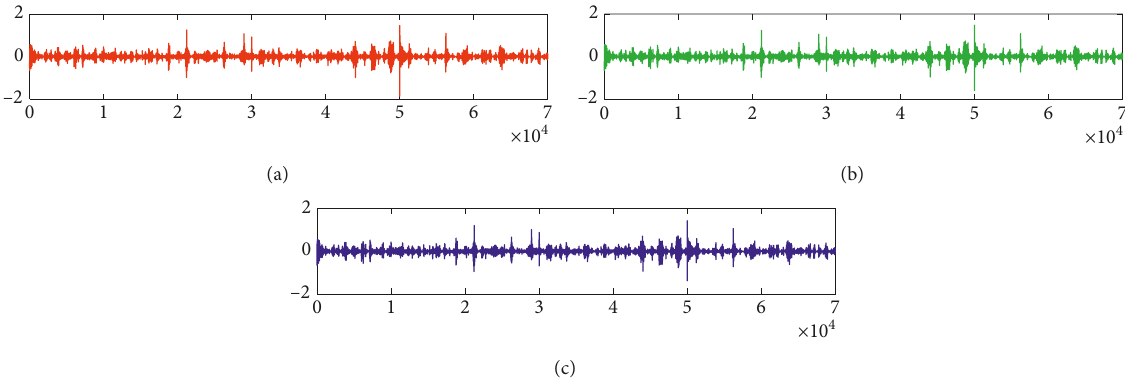
Figure 13: The residual noise of the improved LMS algorithm with signal mutation when (a) α noise.